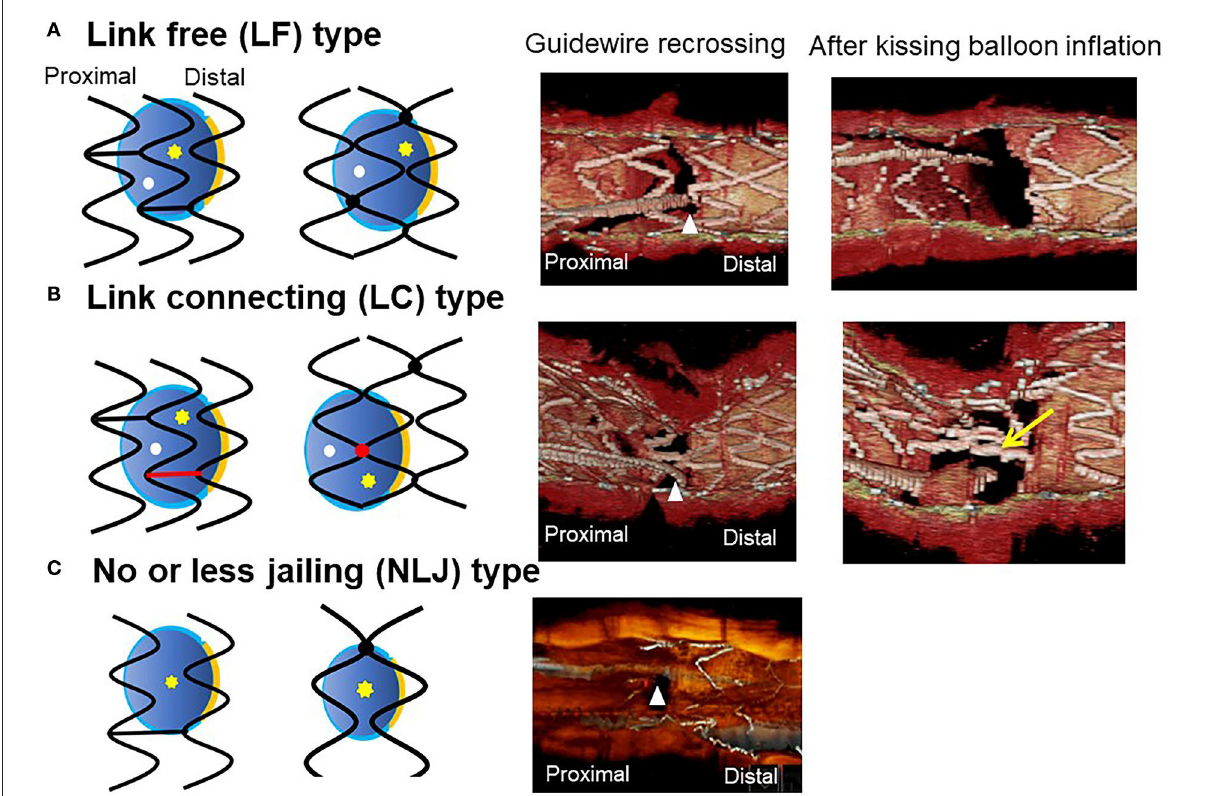
FIGURE9 Classification of jailing strut configuration on the side branch ostium. In the scheme (left: in-phase type stent, right: out-of-phase type stent), orange line indicates the carina, red color indicates the link between hoops connecting to the carina, yellow asterisks, and white dots indicate the distal and proximal recrossing position. Middle column: 3D optical coherence tomography (OCT) image of guidewire recrossing point. Right column: 3D OCT image after final kissing balloon inflation (KBI). (A) Link-free (LF) type, (B) Link-connecting (LC) type, (C) No or less jailing (NLJ)